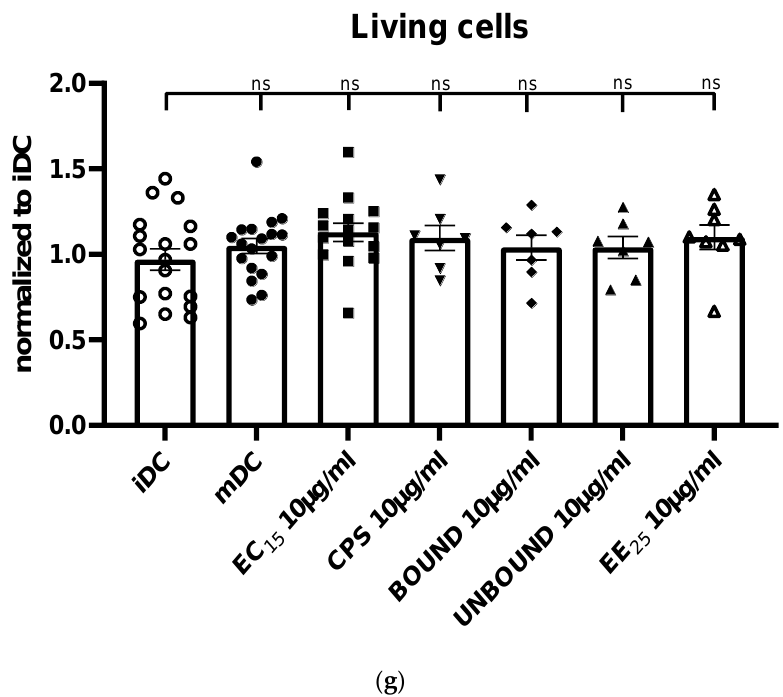
Figure 2. ( a ): Effect of elderberry derived fractions on expression of CD11c in treated iDCs compared to untreated iDCs, and mDCs. Phenotypic cell surface expression was analyzed via flow cytometry. Asterisks mark statistically significant difference (* p < 0.05 and ** p < 0.01). ns: no statistical signifi- cance. (n = 7 – 18). ( b ): Effect of elderberry-derived fractions on expression of MHCII in treated iDCs compared to untreated iDCs, and mDCs. Asterisks mark statistically significant difference (**** p < 0.0001). ns: no statistical significance. (n = 7 – 18). ( c ): Effect of elderberry derived fractions on expres- sion of CD80 in treated iDCs compared to untreated iDCs, and mDCs. Asterisks mark statistically significant difference (**** p < 0.0001). ns: no statistical significance. (n = 7 – 18). ( d ): Effect of elder- berry derived fractions on expression of CD86 in treated iDCs compared to untreated iDCs, and mDCs. Asterisks mark statistically significant difference (**** p < 0.0001). ns: no statistical signifi- cance. (n = 7 – 18). ( e ): Effect of elderberry derived fractions on expression of CD40 in treated iDCs compared to untreated iDCs, and mDCs. Asterisks mark statistically significant difference (**** p < 0.0001). ns: no statistical significance. (n = 7 – 18). ( f ): Effect of elderberry-derived fractions on expres- sion of CD83 in treated iDCs compared to untreated iDCs and mDCs. Asterisks mark statistically significant difference (*** p < 0.001 and **** p < 0.0001). ns: no statistical significance. (n = 7 – 18). ( g ): Effect of elderberry-derived fractions on cell viability using 7-AAD cells. None of the elderberry extracts and fractions, that is, EC15, CPS, BOUND, UNBOUND, or EE25, induced significant levels of cell death when compared to untreated control iDCs. For dead cell discrimination, 7-AAD viabil- ity staining solution was directly added to the surface staining, prior to subsequent FACS analyses.